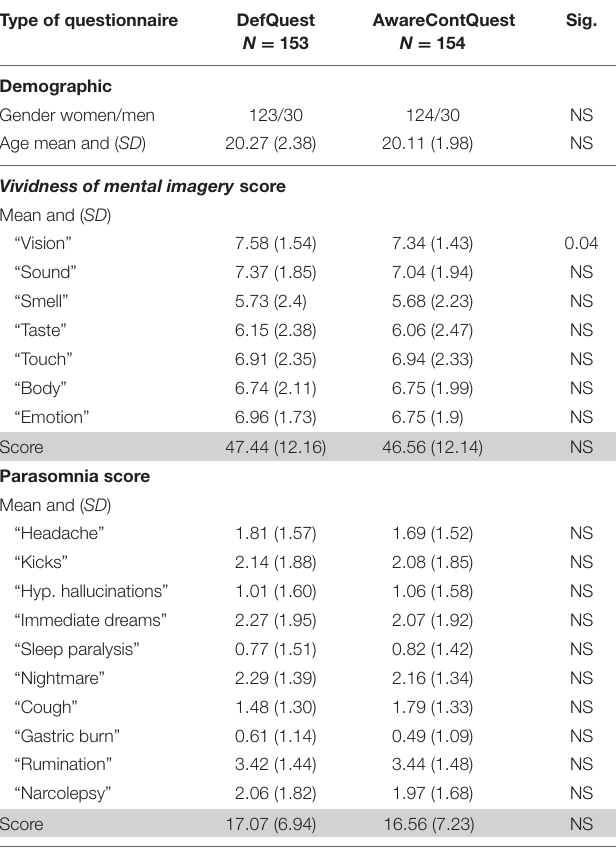
TABLE 2 | Descriptive data and significance of the Chi-square and Mann-Whitney tests between the two experimental groups (DefQuest and